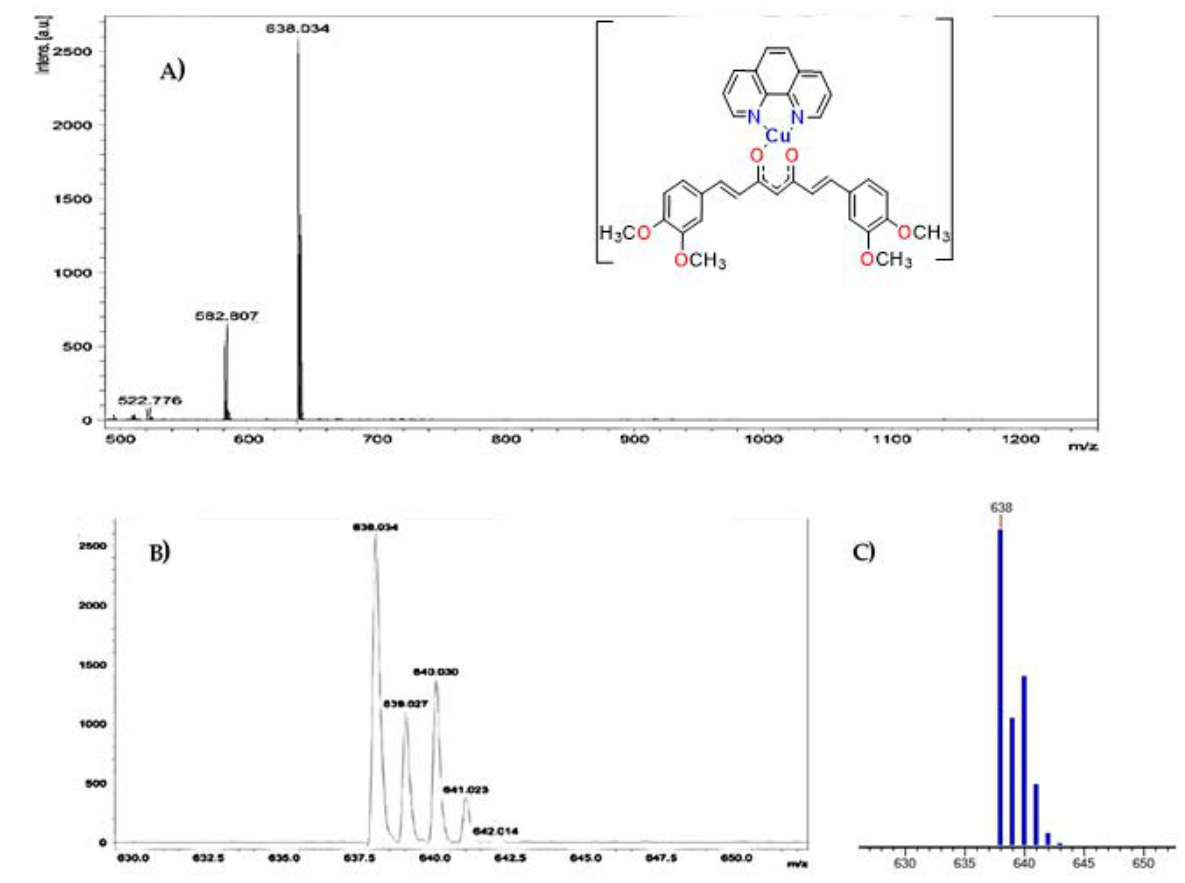
Figure 5. ( A ) MALDI-TOF mass spectra of [L4CuL2]+; ( B ) calculated isotopic spectral pattern of complex theoretical and ( C ) isotopic spectral